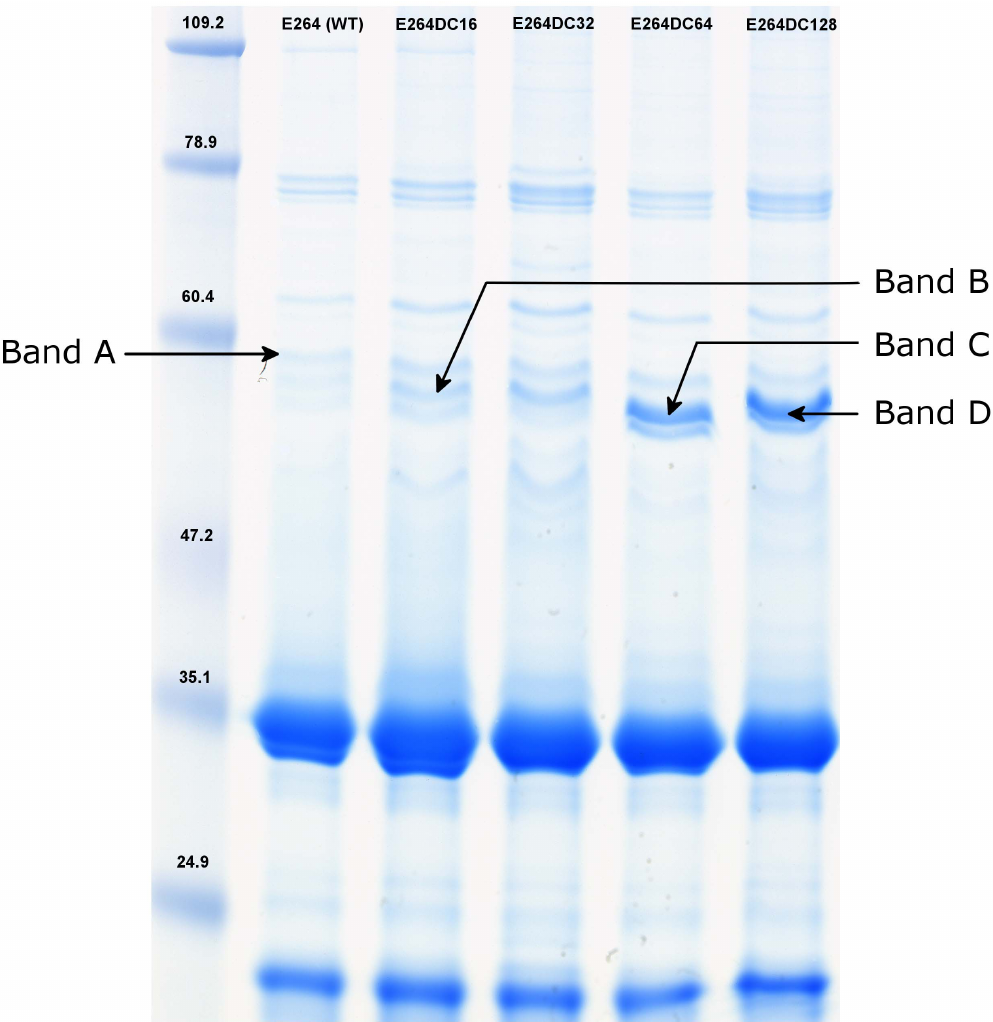
Figure 1. Analyses of the detergent-insoluble membrane proteins of doxycycline-resistant variants. SDS-PAGE analysis was performed on the E264 wild-type strain of B. thailandensis , and on the four doxycycline-resistant derivative strains, E264DC16, E264DC32, E264DC64 and E264DC128. Proteins were stained with Coomassie blue. The variants presented additional bands at around 58 kDa (band A), 55 kDa (band B) and at 54 kDa (bands C and band D). Molecular weight standards are indicated in kilodaltons.